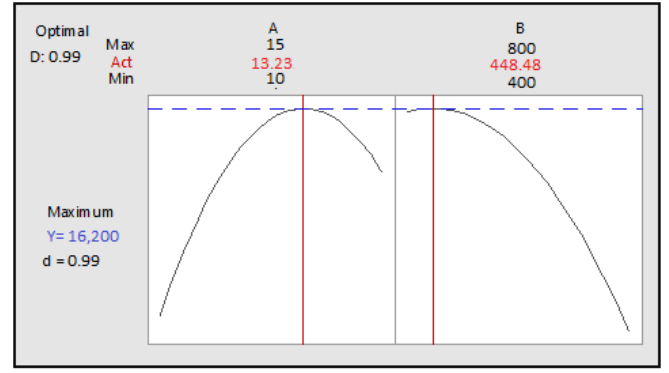
Figure 12. Optimization of two cooking time and power according to desirability; A: cooking time; B: power.